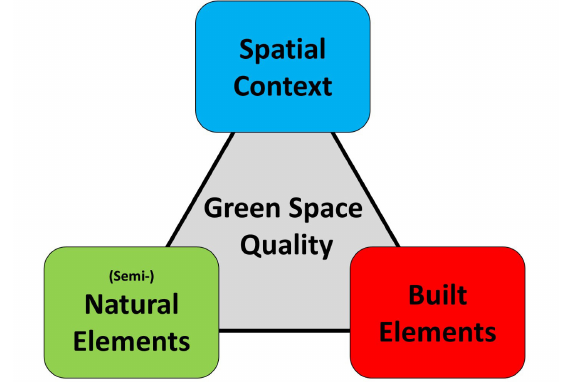
Fig. 1 . The three-dimensional composite of urban green space quality applied in this study (adapted from Voigt et al.